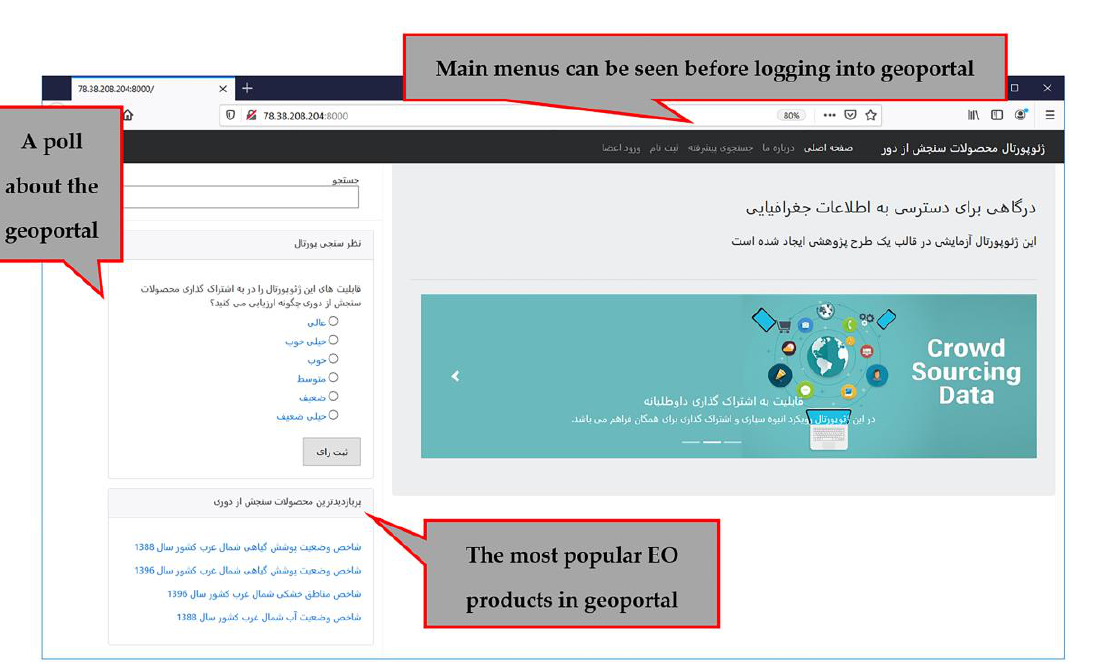
Figure 8. Advanced search for finding an Earth observation (EO) product service based on location boundary on the map and metadata such as category, title, a term in the description, and time span; the result includes the name of map service, a snippet of the description, the thumbnail, and a link to details.